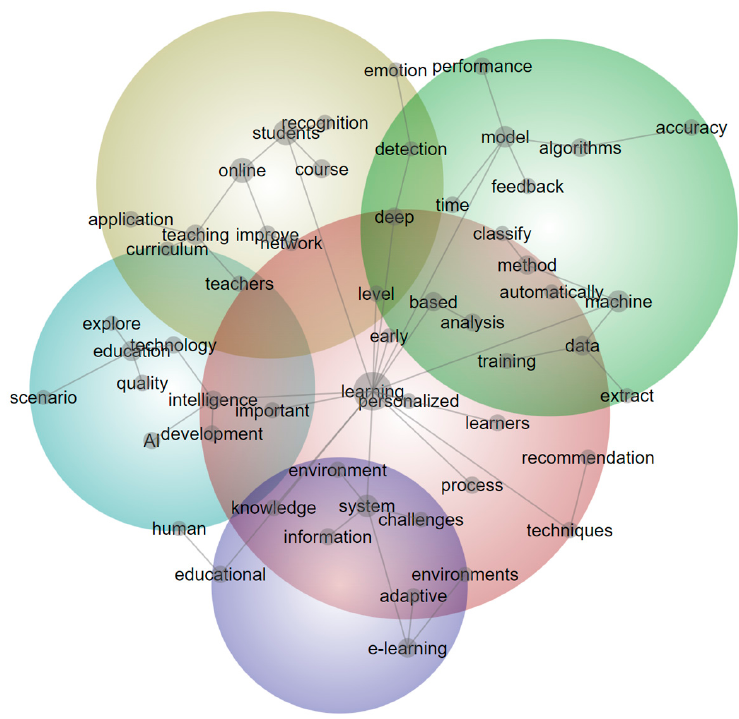
Figure 5. Concept map of abstracts visualized through text mining.